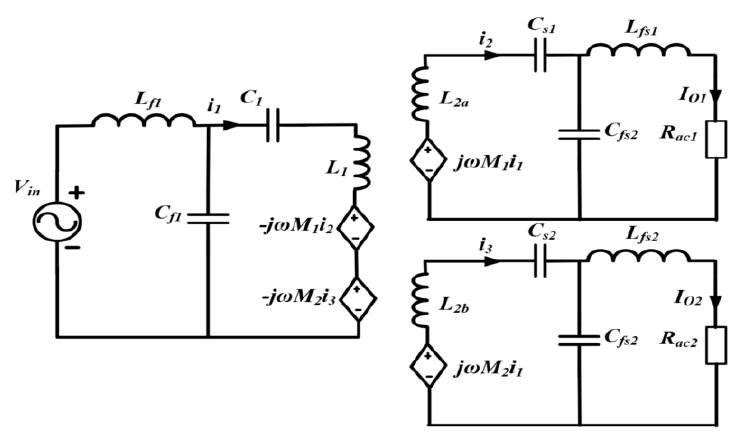
Figure 24. Equivalent decoupled circuit model of LCC-LCC compensation of the primary side (DD) and the secondary side (BP). Table 11. Compensation parameters for 48 V IPT system.